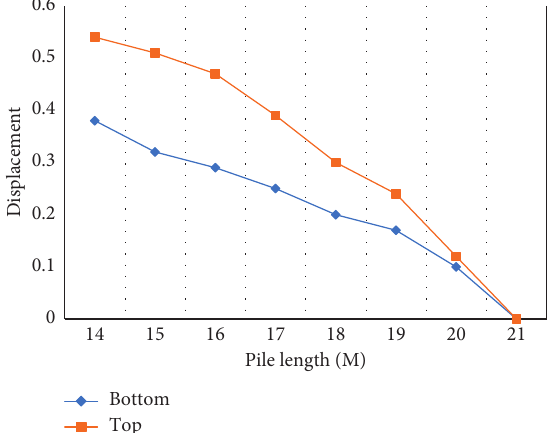
Figure 6: Displacement curves of ancient buildings with different pile